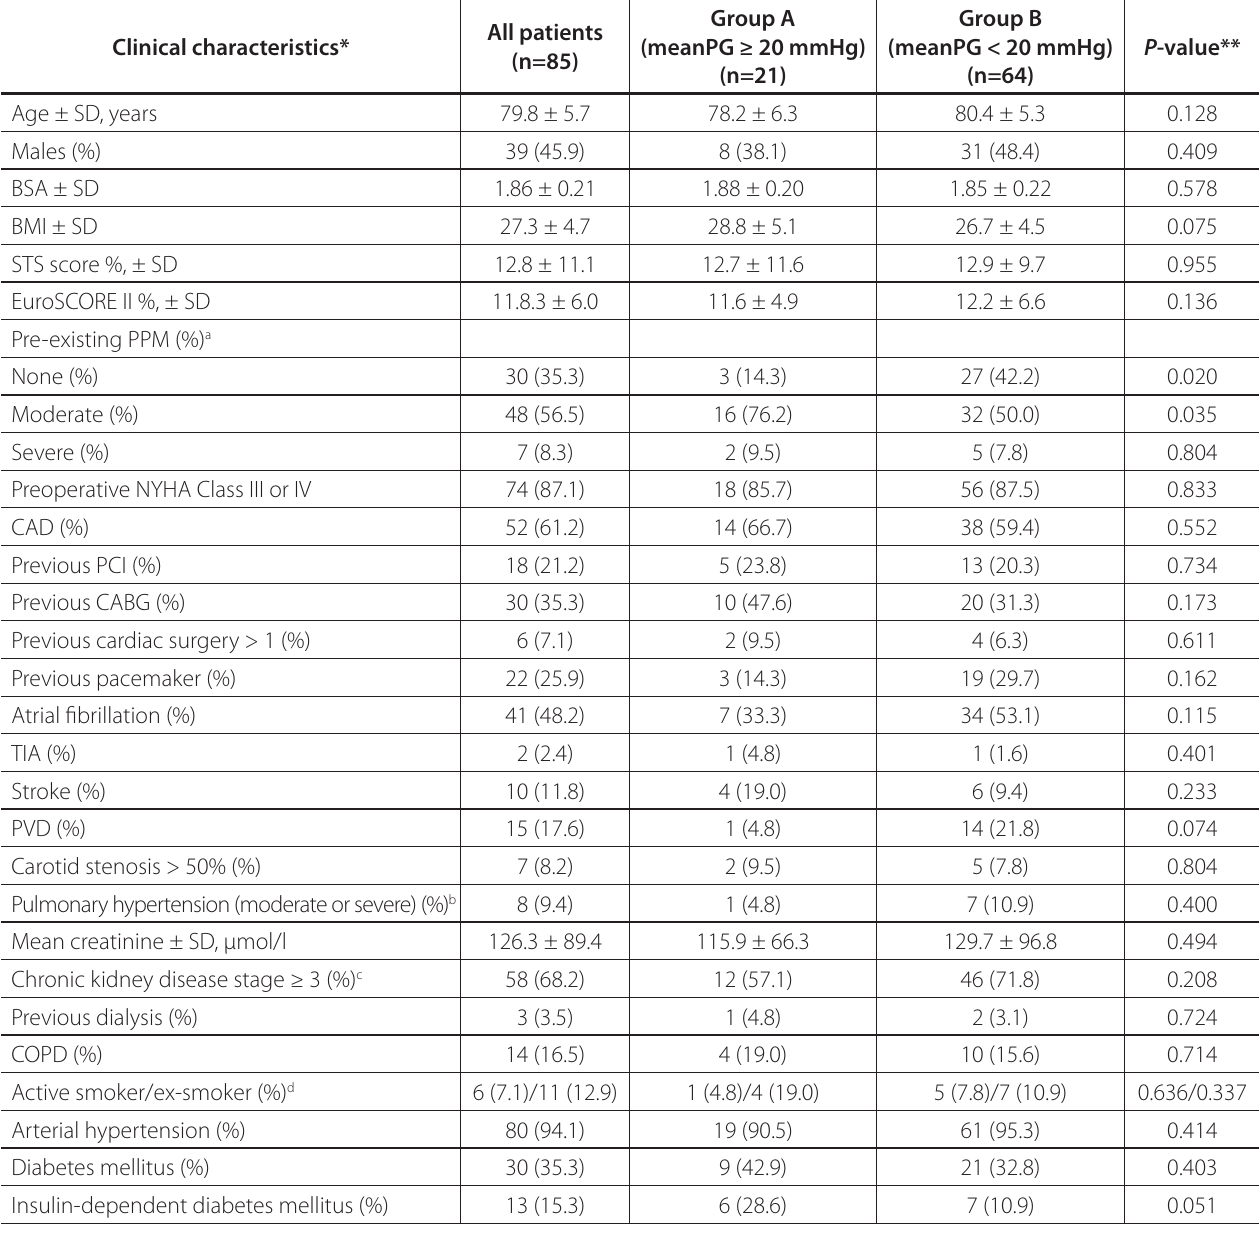
Table 1 . Patients’ demographic, clinical, and echocardiographic characteristics. Clinical